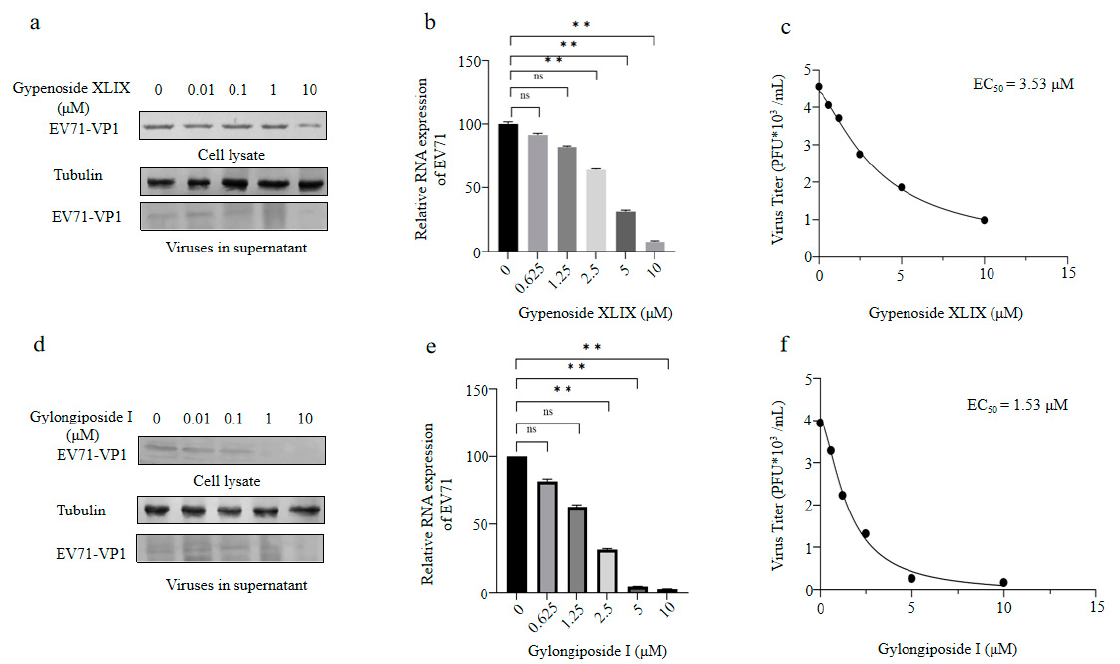
Figure 8. Anti-EV71 activity of gypenoside XLIX and gylongiposide I. ( a ) The inhibitory effect of gypenoside XLIX on EV71 replication in the 0–10 µ M dose range. RD cells were infected with EV71 at an MOI of 2 for 4 h, washed twice with DMEM and supplemented with DMEM containing the indicated concentration of gypenoside XLIX for another 48 h. The cells were harvested for Western blot (WB) analysis, and tubulin was used as a loading control. The supernatant from the infected RD was centrifuged and then loaded for WB analysis. ( b ) Cellular EV71 RNA levels in Figure 7b were detected by RT-qPCR. GAPDH was used as a control. The EV71 RNA level without gypenoside XLIX treatment was set as 100%. Significant differences are indicated in figures as follows: ** p ≤ 0.01, ns stands for not significant. ( c ) Viral titers in the supernatants from the experiment shown in Figure 7b were determined by the plaque assay. The EC 50 of gypenoside XLIX was calculated by GraphPad Prism7. ( d ) The inhibitory effect of gylongiposide I on EV71 replication in the 0–10 µ M dose range. RD cells were infected with EV71 at an MOI of 2 for 4 h, washed twice with DMEM and supplemented with DMEM containing the indicated concentration of gylongiposide I for another 48 h. The cells and supernatants were harvested for WB analysis. ( e ) Cellular EV71 RNA levels in Figure 7e were detected by RT-qPCR. GAPDH was used as a control. The EV71 RNA level without gylongiposide I treatment was set as 100%. Significant differences are indicated in figures as follows: ** p ≤ 0.01, ns stands for not significant. ( f ) Viral titers in the supernatants from the experiment shown in Figure 7e were determined by the plaque assay. The EC 50 of gylongiposide I was calculated by GraphPad Prism7. The results shown are the means with SDs from two independent